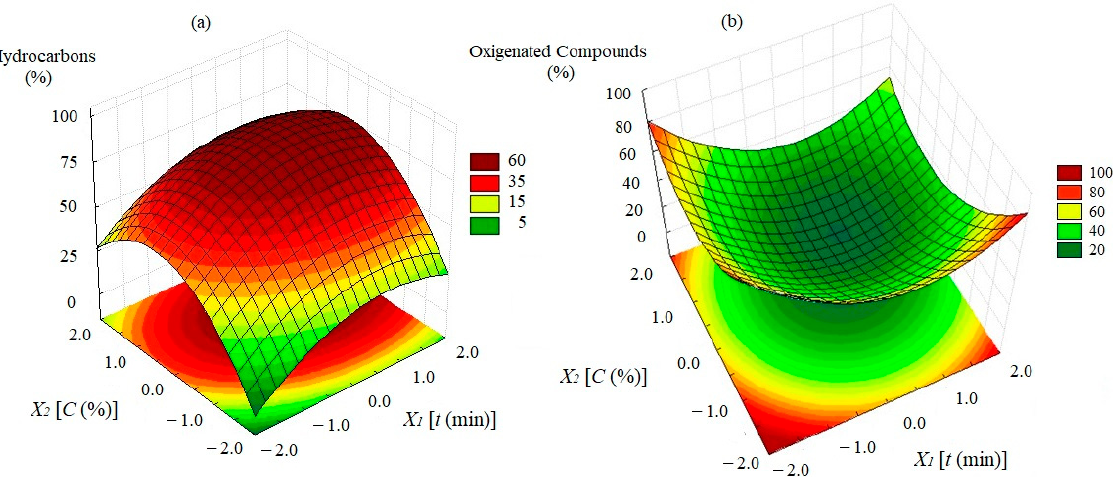
Figure 9. Hydrocarbons ( a ) and oxygenated compounds ( b ) as functions of reaction time ( X 1 ) and percentage of catalyst ( X 2 ).